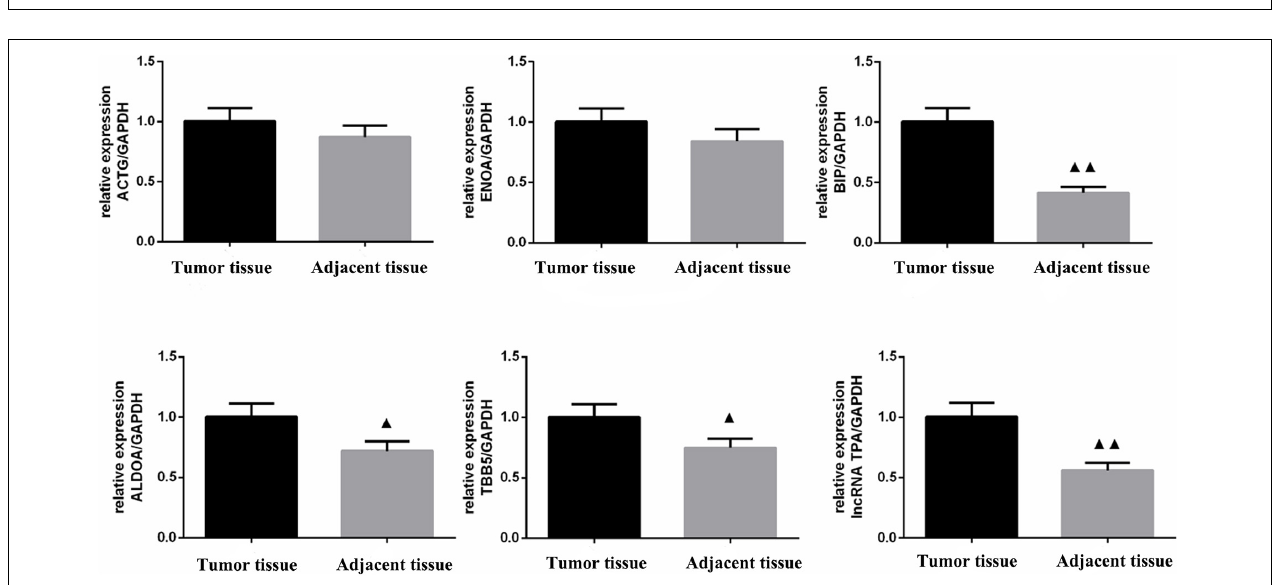
FIGURE 11 | ACTG, ENOA, BIP, ALDOA, TBB5, and lncRNA TPA mRNA expression levels in breast cancer tissues ( χ ± s, n = 3). Compared with the control group, (cid:78) P < 0.05; (cid:78)(cid:78) P < 0.01.